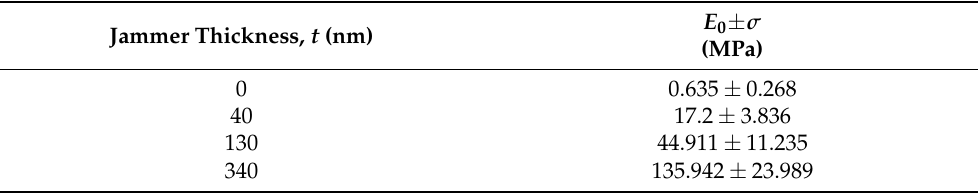
Table 2. Elasticity, E 0 (MPa), approximated by fit the extension F − δ curve with Hertz linear model, F ( δ ) = C n E 0 δ n , where C n is the shape correction of probe tip, n is the power determined by the probe 1 − ν 2 tip shape, and δ is WiMTiP specimen deformation.